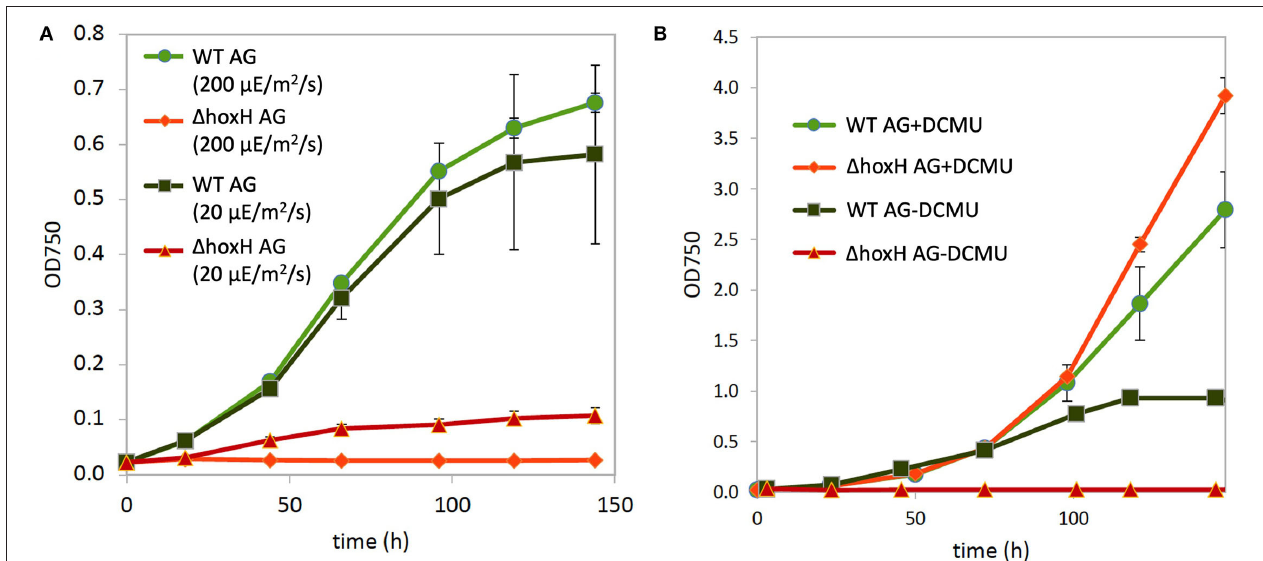
FIGURE 5 | Growth of WT and 1 hoxH on arginine and glucose. (A) Growth at high light (200 µ E/m 2 /s) and low light (20 µ E/m 2 /s). (B) Growth at medium light (60 µ E/m 2 /s) in the absence and presence of the inhibitor DCMU, which blocks electron transfer from PSII to the plastoquinone (PQ) pool.